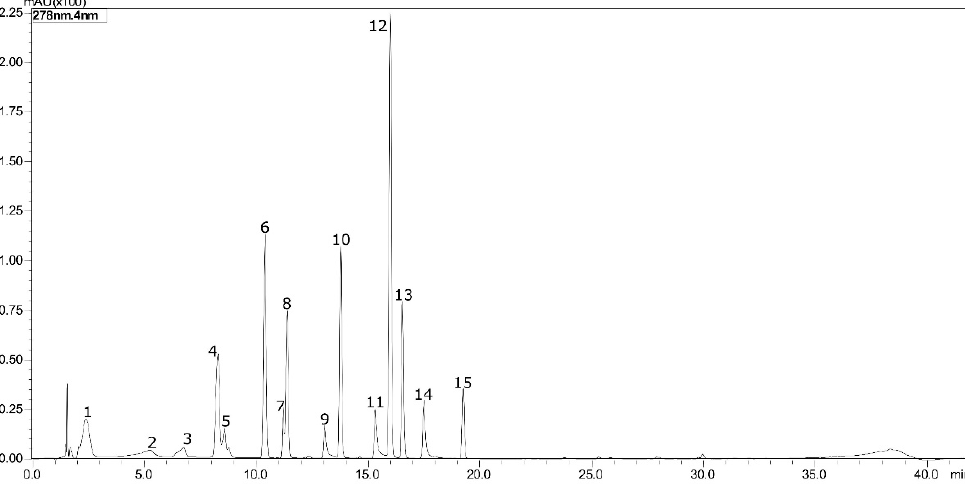
Figure 9. Chromatogram with the phenolic standards evaluated in this study by HPLC-DAD for the identification and quantification of the compounds present in the red propolis extracts obtained under di ff erent conditions (wave length = λ / retention time = RT / detection limit = DL / quantification limit = QL). 1—Gallic acid (RT 2.31 min, λ 280 nm, DL 0.47 mg / g, QL 1.58 mg / g); 2— O -dianiside (RT 4.92, λ 280, DL 0.62 mg / g, QL 2.50 mg / g); 3—Catechin (RT 6.51 min, λ 280 nm, DL 0.31 mg /